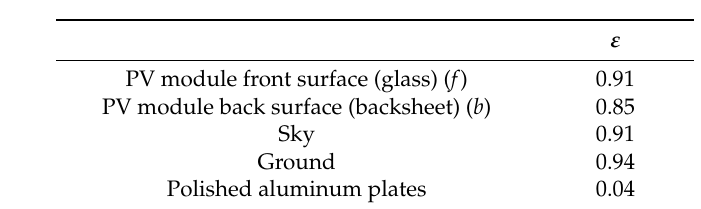
Table 2. Emissivity